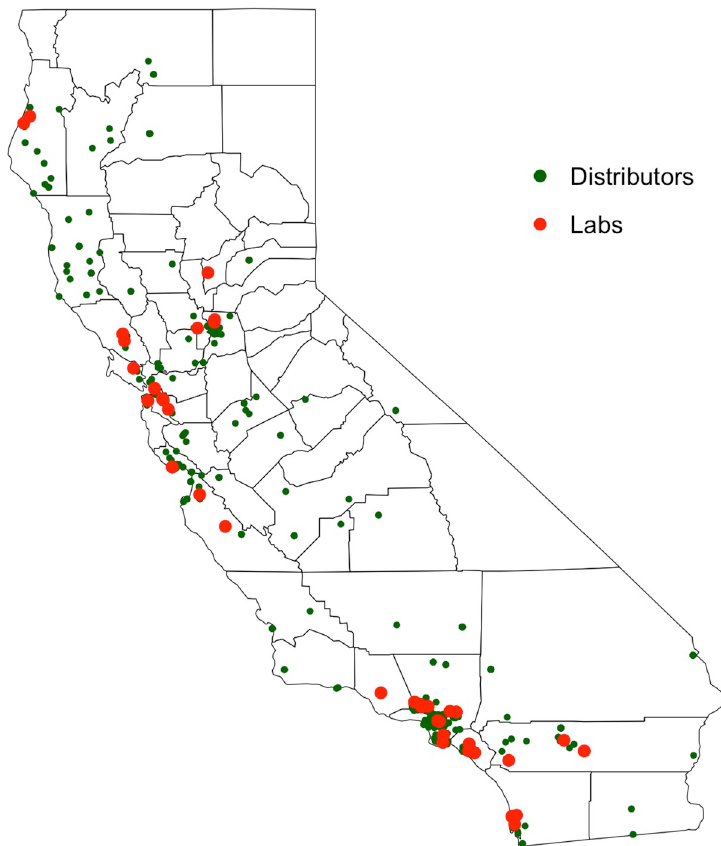
Fig 2. Locations of licensed testing labs and distributors in California. (Source: Bureau of Cannabis Control, April of 2019).